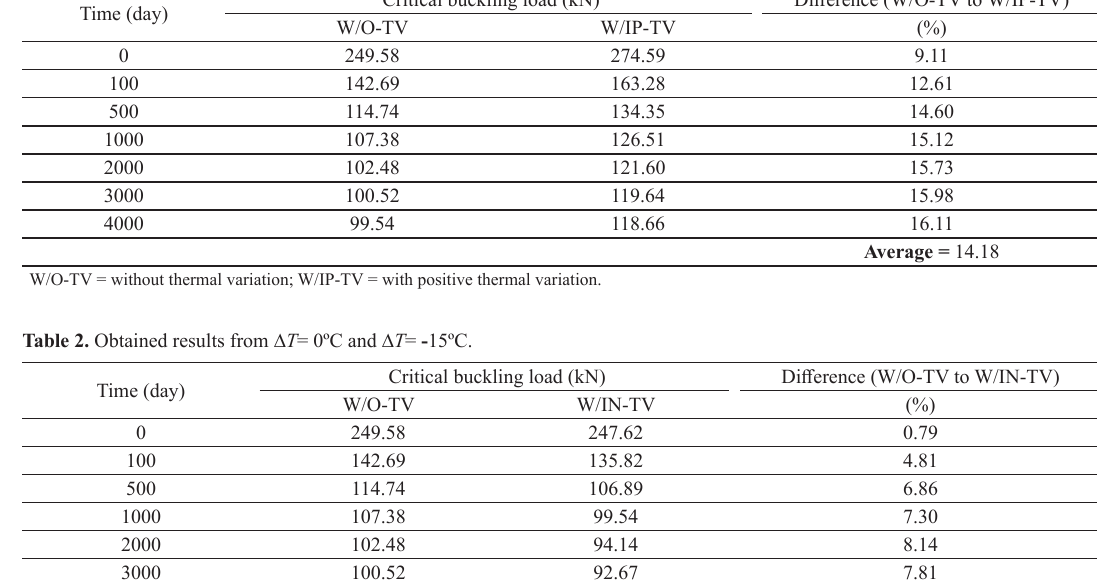
4000 W/O-TV = without thermal variation; W/IN-TV = with negative thermal